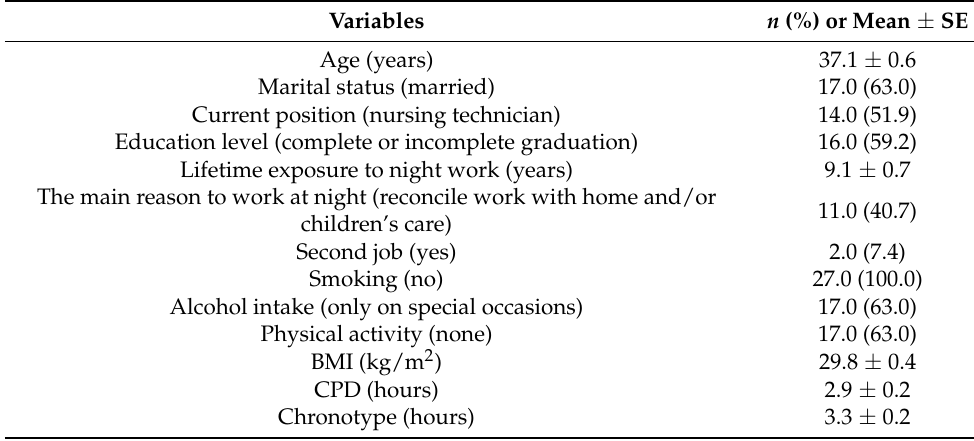
Table 1. Participants’ characteristics at baseline ( n =